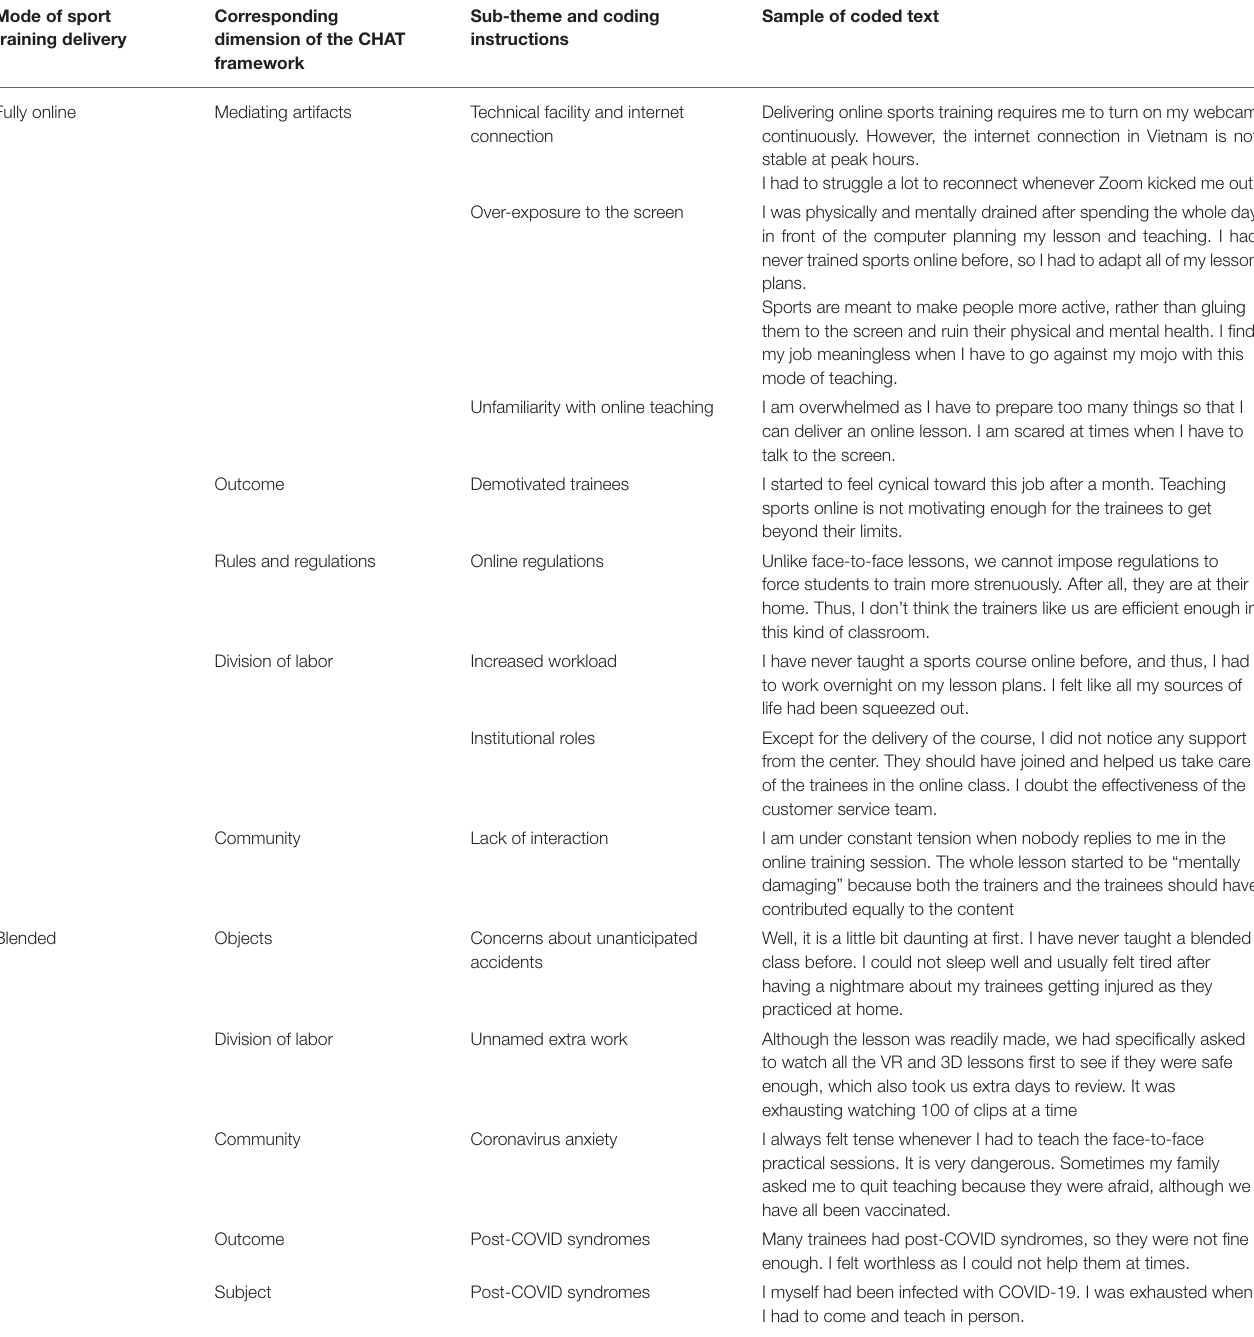
TABLE 2 | Overarching themes and coding